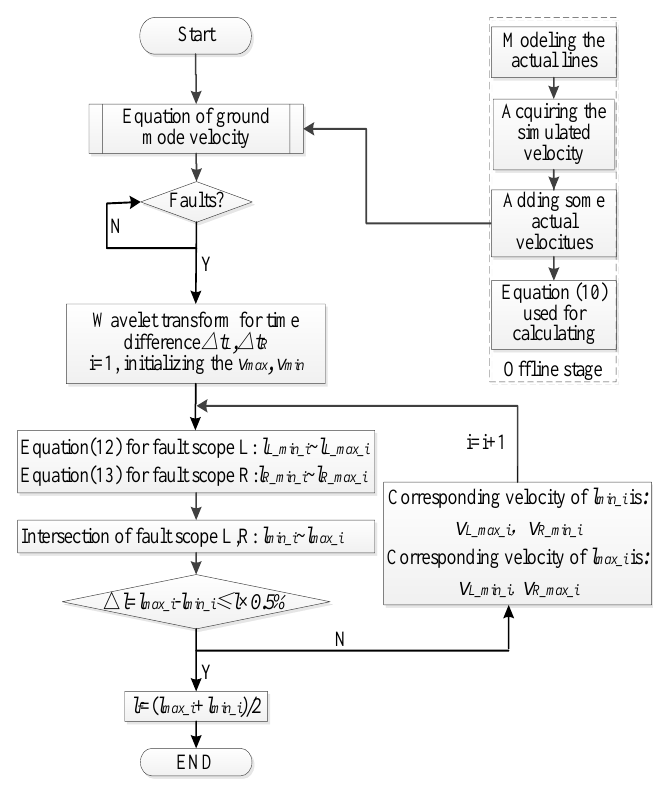
Figure 8. The fault location process.